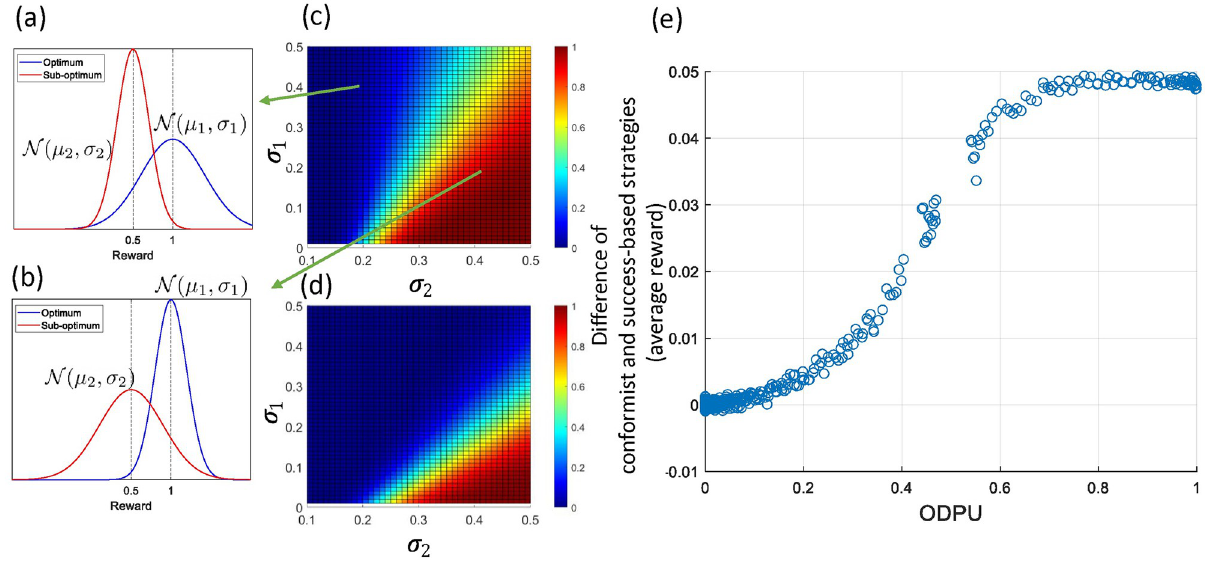
Fig 3. The higher the uncertainty between two distributions (measured by the ODPU) the higher the performance difference between conformist and success-based strategies in terms of average population reward at the end of simulation processes. (a) and (b) illustrate two cases where σ 1 = 0.4, σ 2 = 0.2 and σ 1 = 0.2, σ 2 = 0.4 respectively. (c) and (d) show the ODPU, formalized as the probability of sampling the highest reward value from the sub-optimum distribution, depending on σ 1 and σ 2 and the ratios of samples drawn independently from the optimum and sub-optimum reward distributions. In (c) the ratios of samples drawn from the optimum and sub-optimum distributions are 0.05 and 0.95, and in (d) the ratios are 0.5 and 0.5 respectively. (e) shows the relation between the ODPU and the difference in average reward at the end of the process between the populations with conformist and success-based strategies.